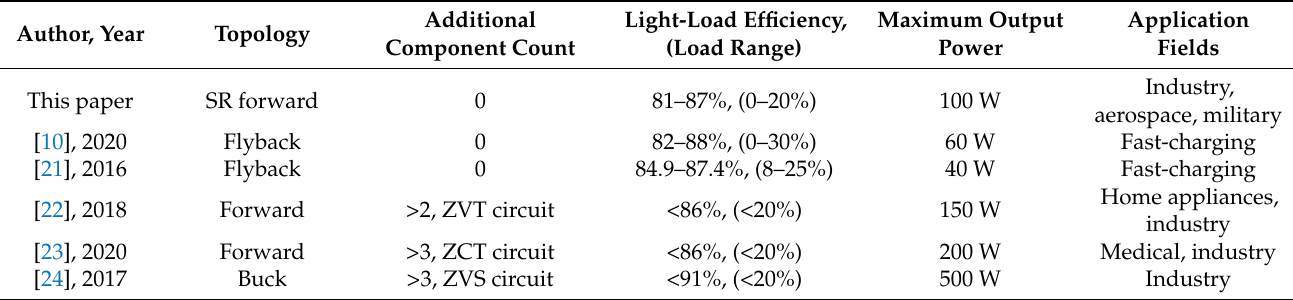
Table 4. Comparison with other soft-switching